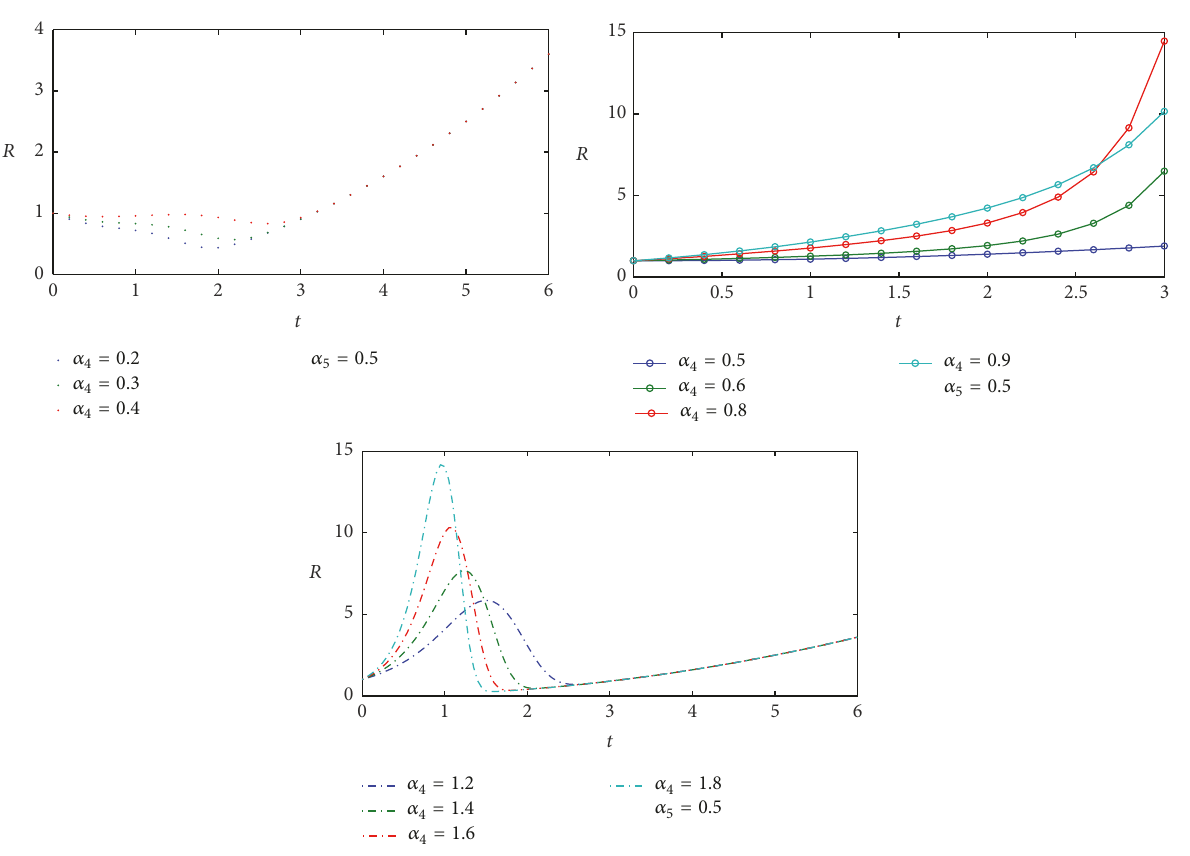
Figure 13: Variation of scale factor against time for fixed 𝛼 5 = 0.5 and different 𝛼 4